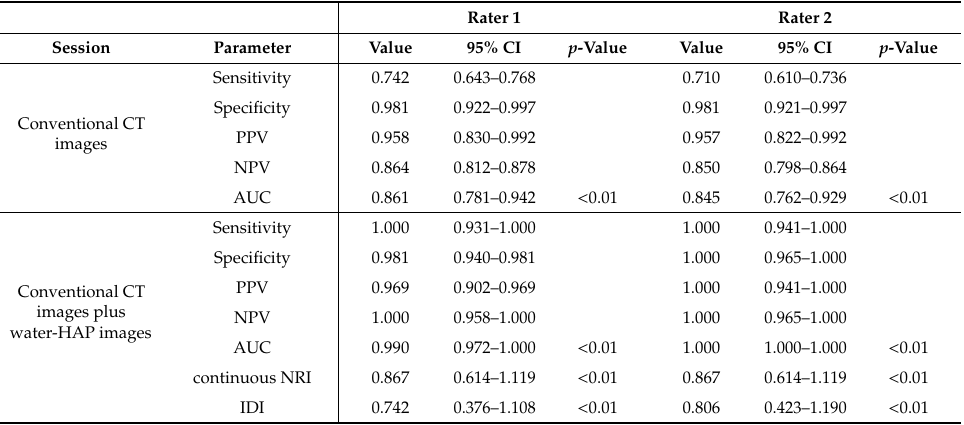
Table 4. Diagnostic performance of conventional CT images and conventional CT images plus water-HAP